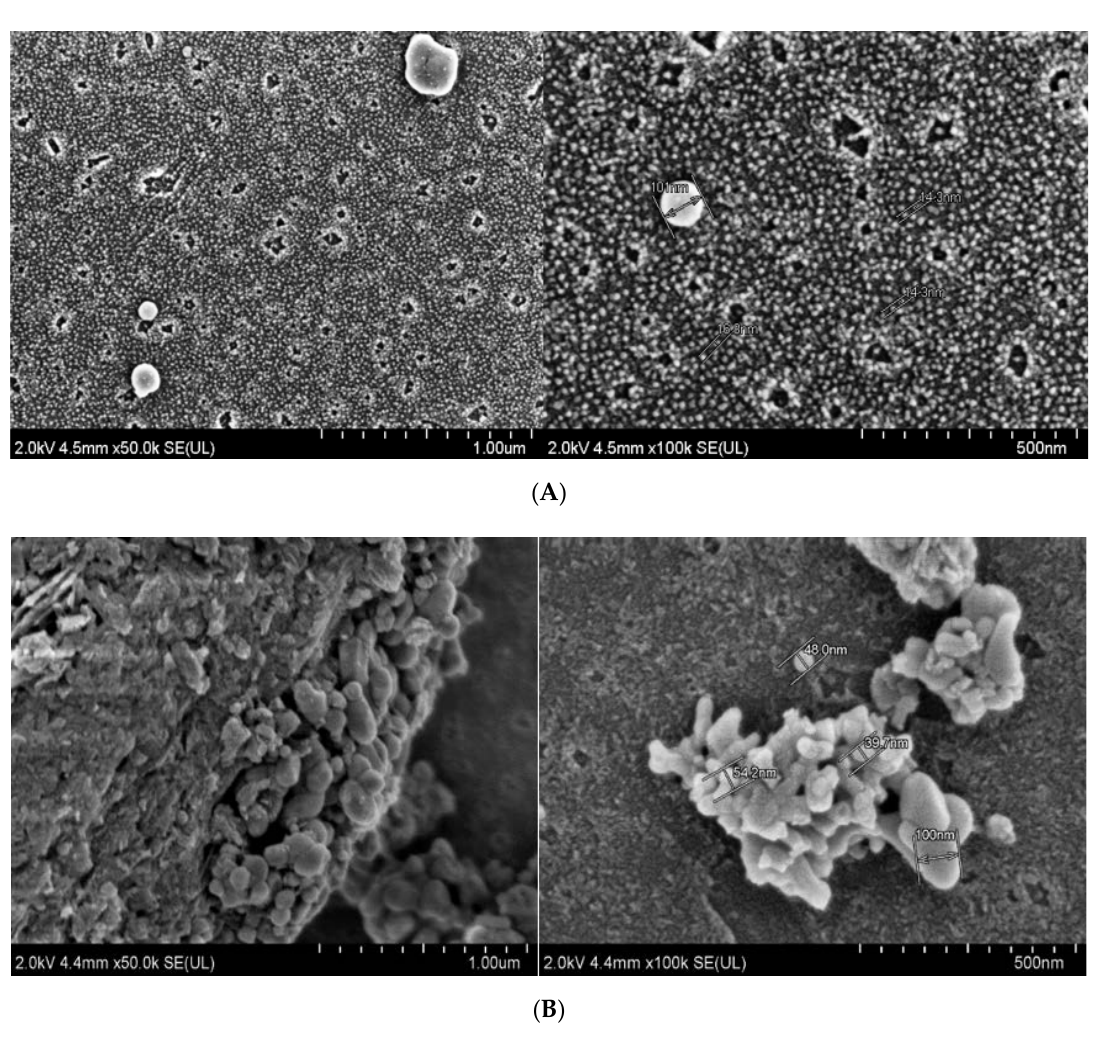
Figure 1. FESEM micrographs of ( A ) GBA suspension in 1 mg/mL and ( B ) GBA suspension in 10 mg/mL. The suspension was prepared in water, followed by incubation at 37 °C for 30 min and supplementation with 10% FBS. The FESEM micrographs of GBA suspension were captured at both low resolution (1 µm) and high resolution (500 nm).